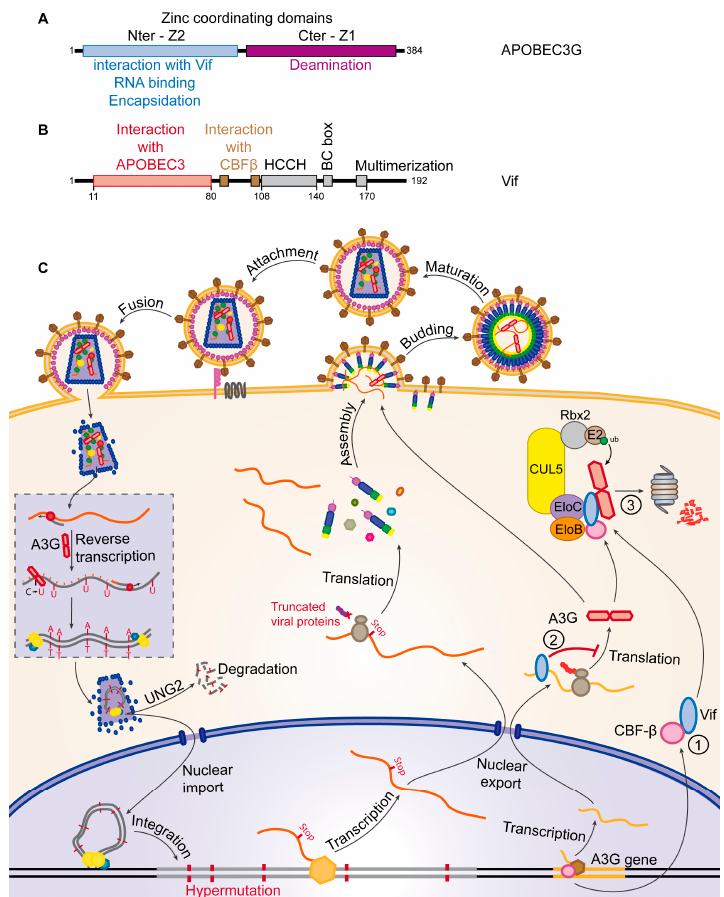
Figure 4. Restriction of HIV by APOBEC3G and counteraction by Vif. ( A , B ) Schematic representation of the main domains of ( A ) the APOBEC3G and ( B ) Vif proteins. Amino acid positions of the beginning and end of the domains as well as the total length of the proteins are indicated; ( C ) the mechanism of APOBEC3G restriction and Vif counteraction. APOBEC3G (red) is incorporated into of truncated viral proteins. Vif (blue) decreases A3G transcription ① , inhibits its translation ② (Red T bar) and induces its degradation by the proteasome ③